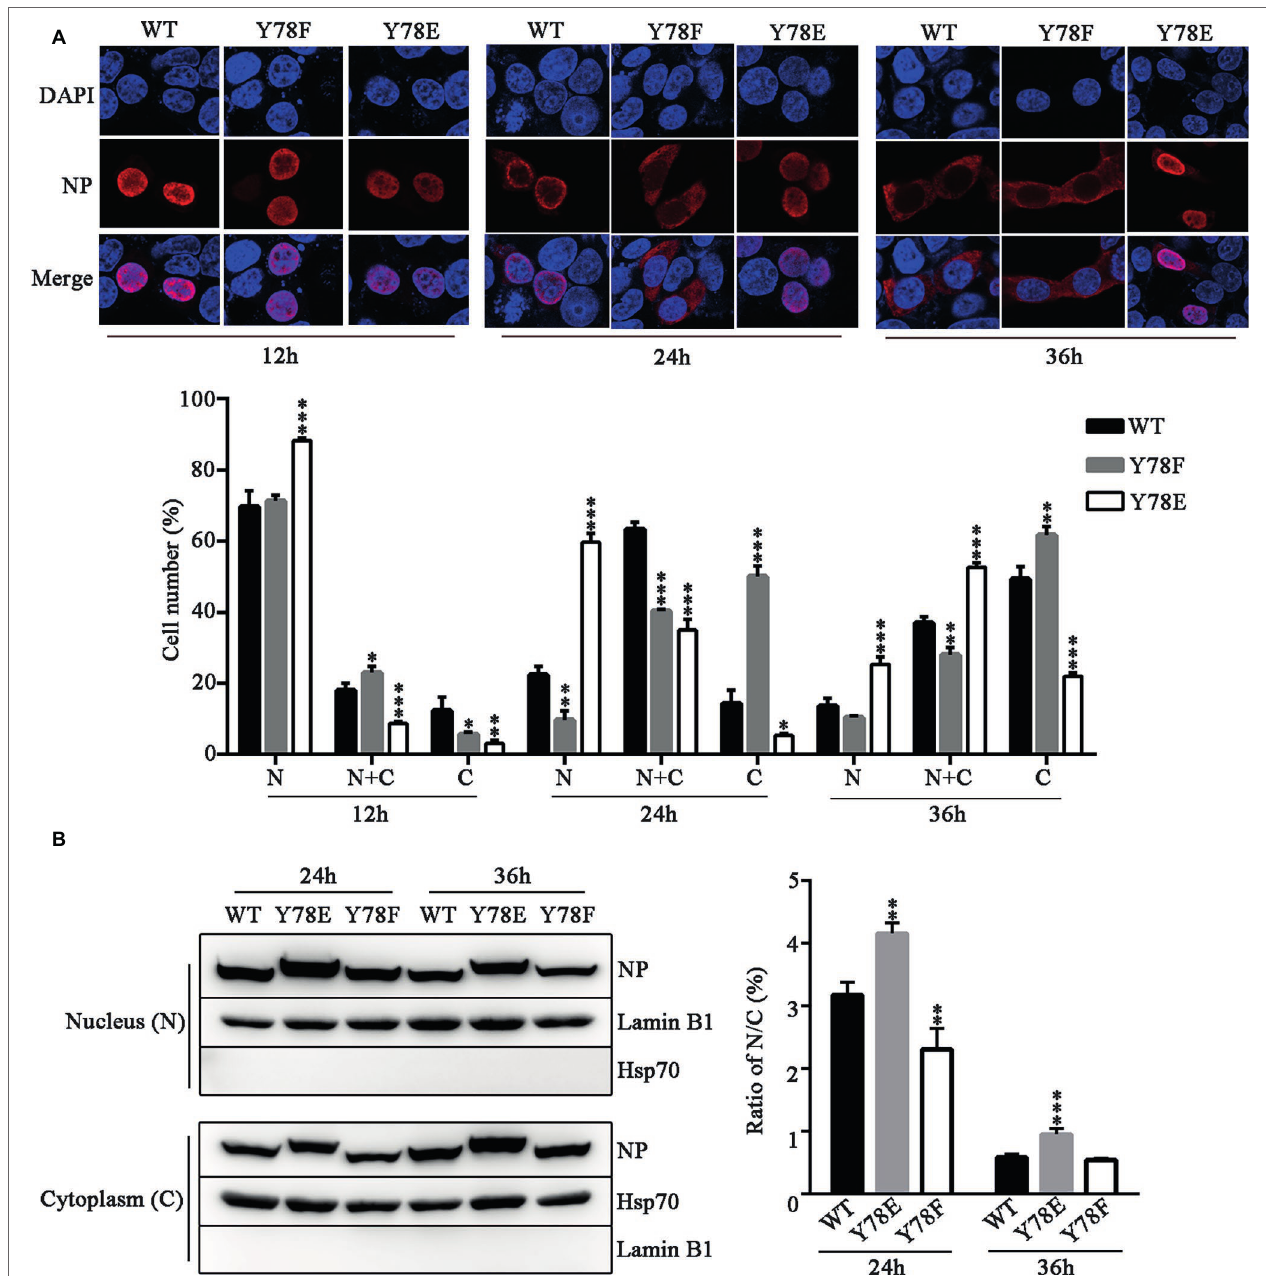
FIGURE 3 | Y78 phosphorylation inhibits the nuclear export of NP. (A) The cellular localizations of WT and mutant NPs (Y78F and Y78E) were determined using IFAs. 293 T cells were transfected with plasmids expressing WT or mutant NPs. Cells were fixed at 12, 24, and 36 h.p.t. The nucleus was stained with DAPI (blue), and the subcellular distribution of NP (red) was analyzed (top). At least 600 cells from each condition were scored as predominantly nuclear (N), nuclear and cytoplasmic (N + C), or predominantly cytoplasmic (C) (below), and the percentage of cells representing each is shown. Differences of cellular localization between the mutant and WT NPs were evaluated using one-way ANOVA followed by Dunnett’s test. Data are shown as mean + SD ( n = 3). * p < 0.05; ** p < 0.01; *** p < 0.001. (B) Immunoblot analysis of the subcellular location of NP. 293 T cells were transfected with plasmid expressing WT, Y78F, or Y78E NP. The nuclear and cytoplasmic fractions were separated at 24 and 36 h.p.t. and detected using anti-NP and anti-Lamin B1 or anti-Hsp70 antibody (left). Nuclear NP was normalized to Lamin B1, and cytoplasmic NP was normalized to Hsp70. Data are shown as mean + SD ( n = 3). The differences of N/C ratio between mutant and WT NPs were evaluated using one-way ANOVA followed by Dunnett’s test (right). ** p < 0.01; *** p <